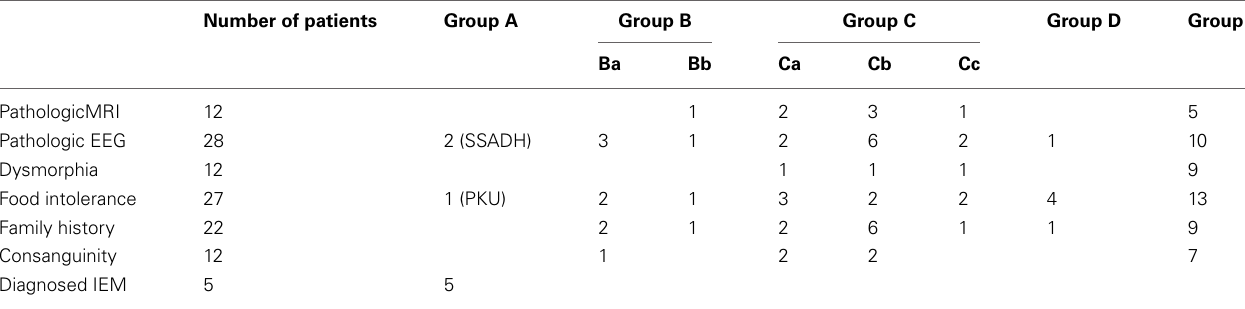
Table 5 | Distribution of pathological findings corresponding to subgroups depicted in Figure 1. Number of patients